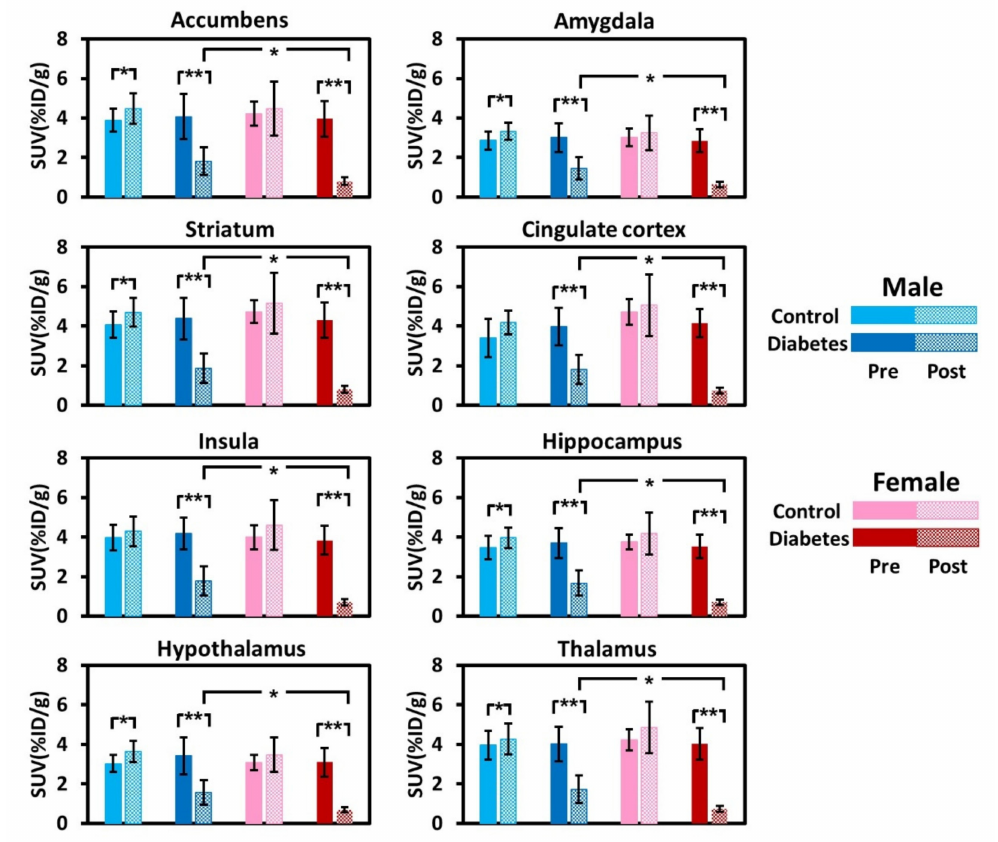
Figure 3. 18 F-fluorodeoxyglucose uptake values of the regions of interest averaged across rats in the control and diabetes groups between sexes. SUV, standardized uptake value. *: p < 0.05; **: p < 0.01.